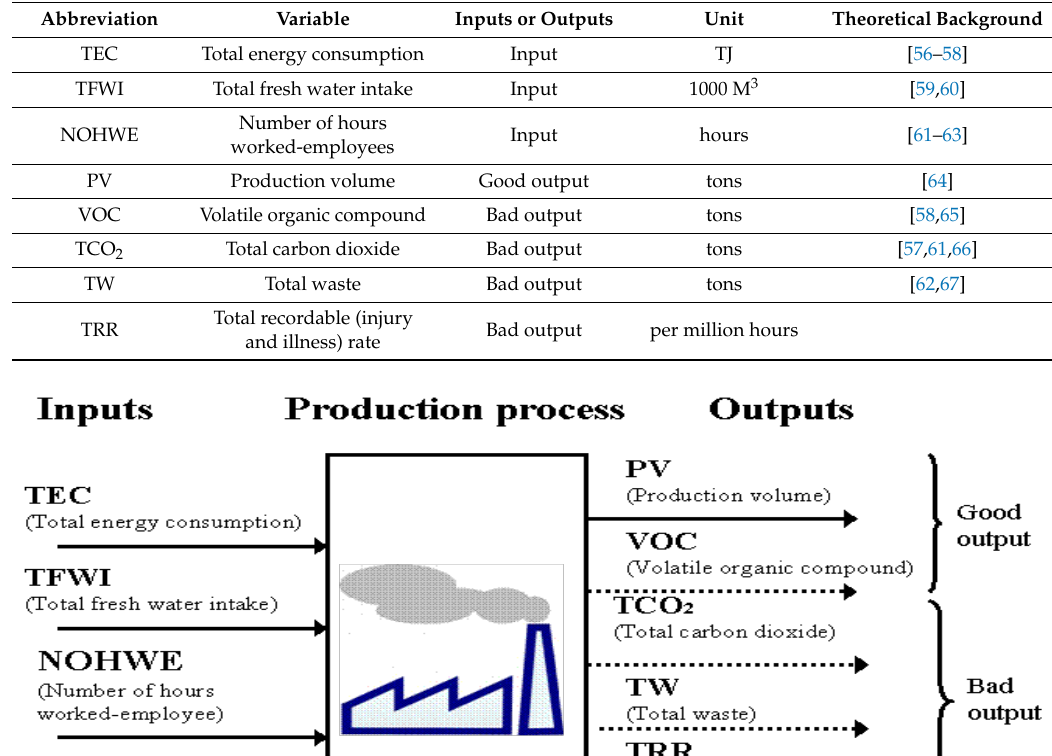
Table 2. Input and output variables in the DEA model.